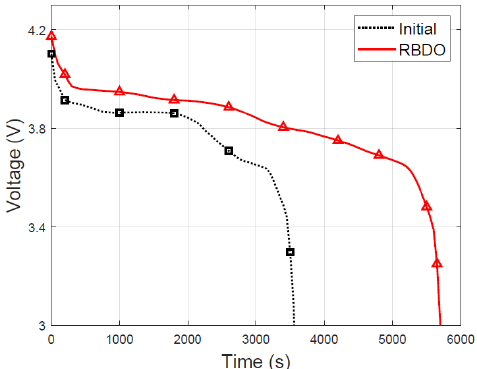
Figure 9. Comparison of discharge voltage between the initial and optimized designs.